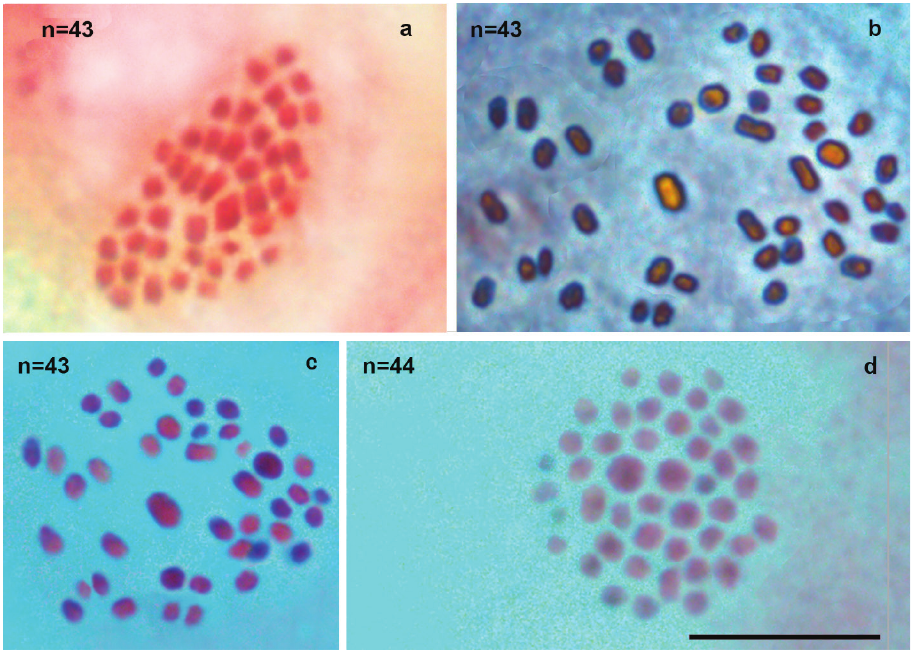
Figure 6. Karyotype of two putative hybrid specimens from the contact zone between P. orphicus and P. lurae sp. nov, where both orph2 and aroa3 haplogroups are present a sample K69, MII, n=43 b–d sam- ple 17-094-3: b MI, n=43 (phase-contrast) c MI, n=43; d MI, n=44. Scale bar: 10